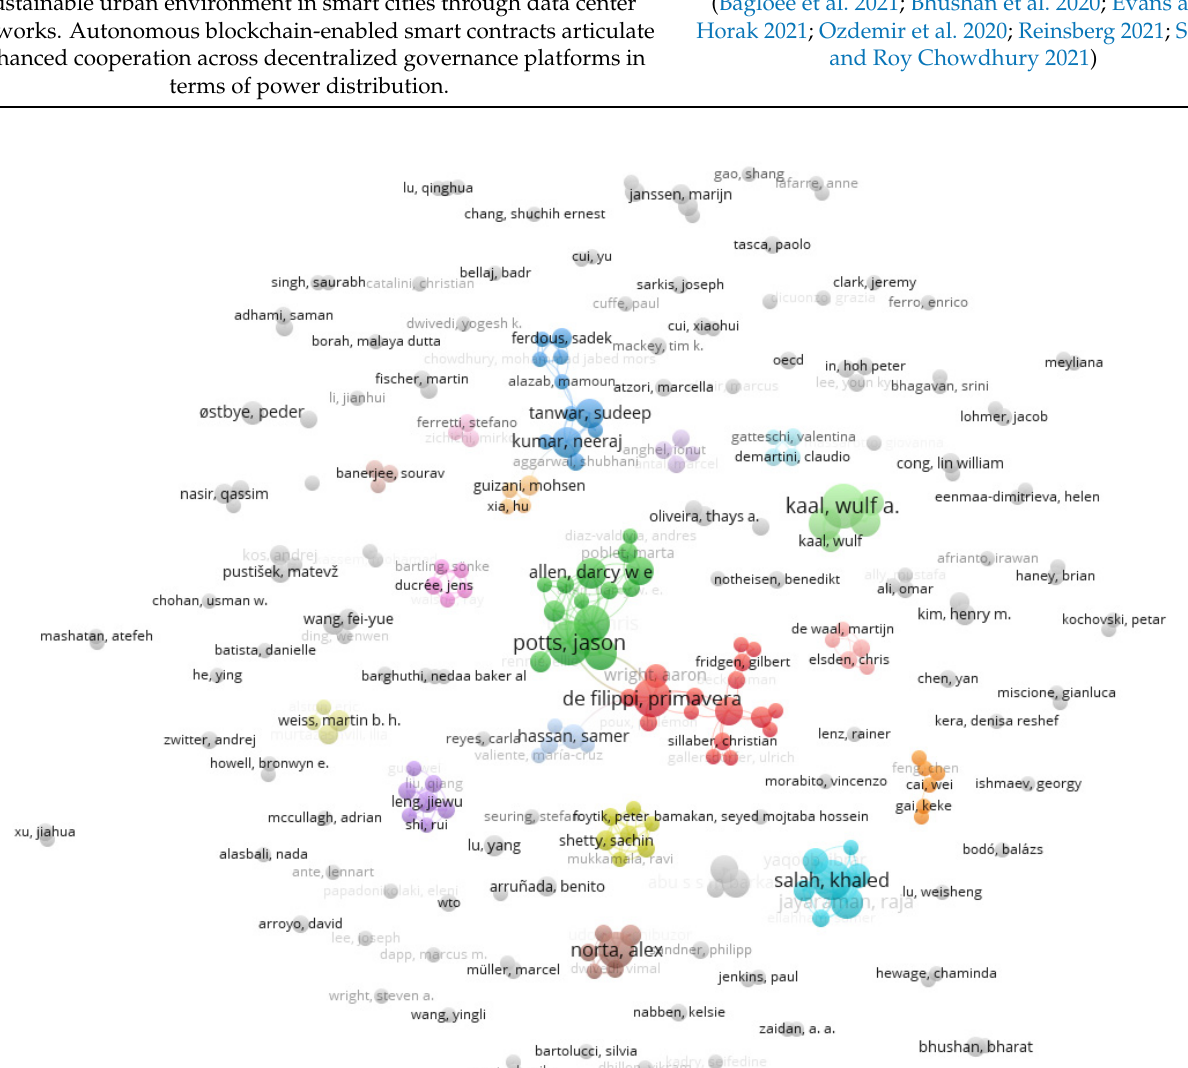
Figure 2. VOSviewer mapping of blockchain technology and smart contracts in decentralized governance systems regarding citation.